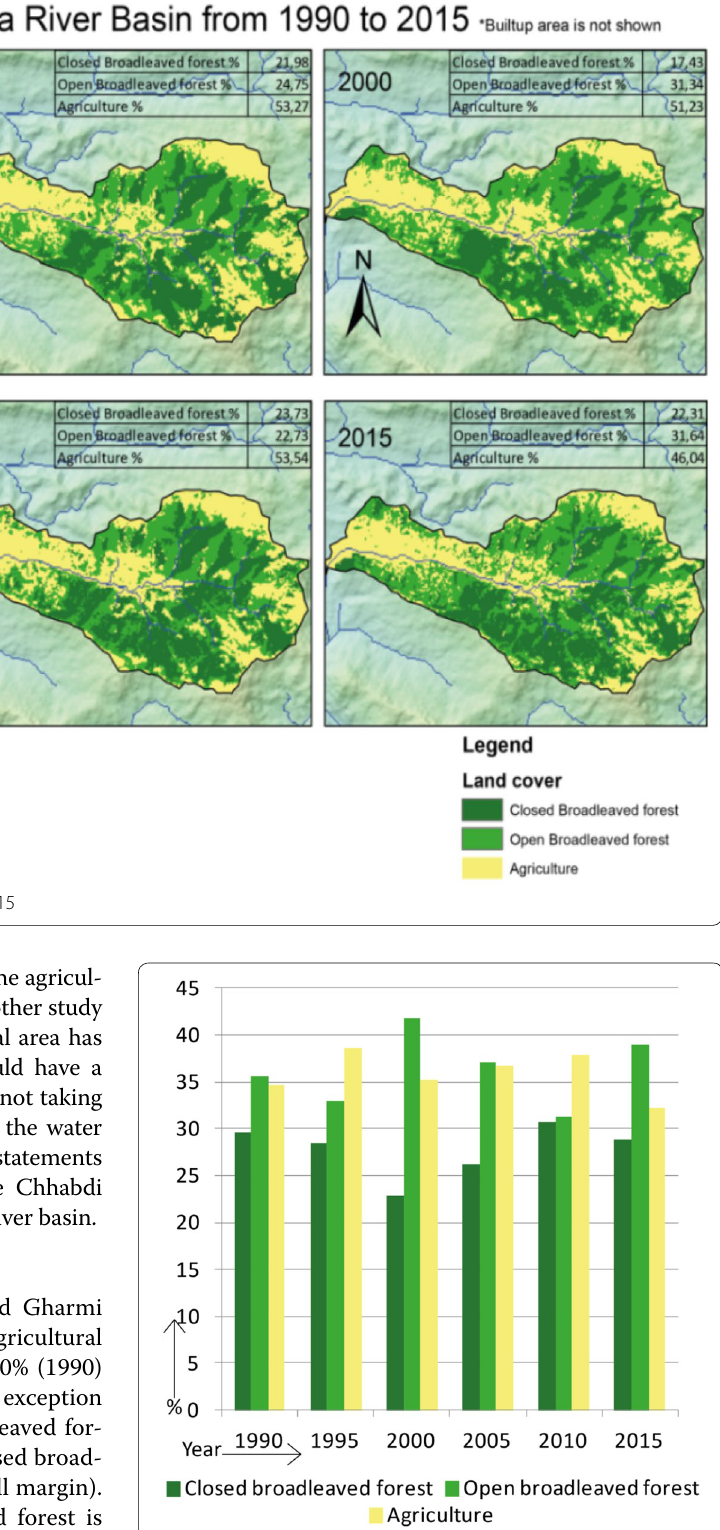
Fig. 5 Graph illustrating changes in various land cover for the Chhabdi Khola